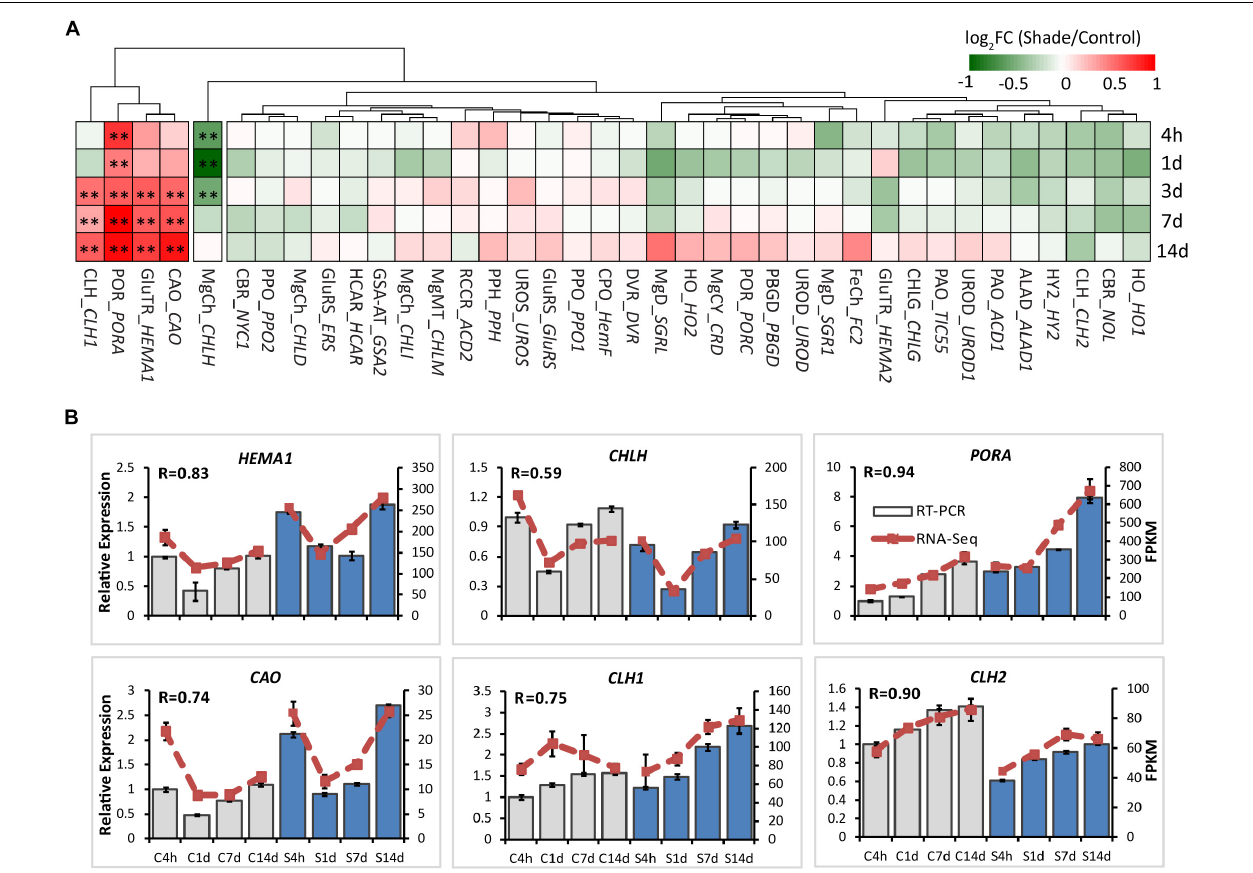
FIGURE 4 | Effect of shade on key genes and TFs involved in chloroplast biogenesis. (A) Transcript abundance of representative unigenes involved in chloroplast biogenesis generated from RNA-Seq analysis. (B) Transcript abundance of selected unigenes validated by the RT-PCR analysis. The column presents data generated from the RT-PCR analysis (gray column, data from the control treatment at four time points; blue column, data from the shade treatment at four time points). The line presents data generated from the RNA-Seq analysis. The transcript abundance in the control treatment at 4 h (C4h) was set at 1. R, the correlation factor between RT-PCR and RNA-Seq analysis for each gene/TF according to SPSS 13.0 software. Data shown are conducted of three independent biological replicates ( n = 3). The annotations of 4h, 1d, 3d, 7d, 14d, C, S, FPKM and statistical label (*) are shown as in Figure 3 . For abbreviations, see